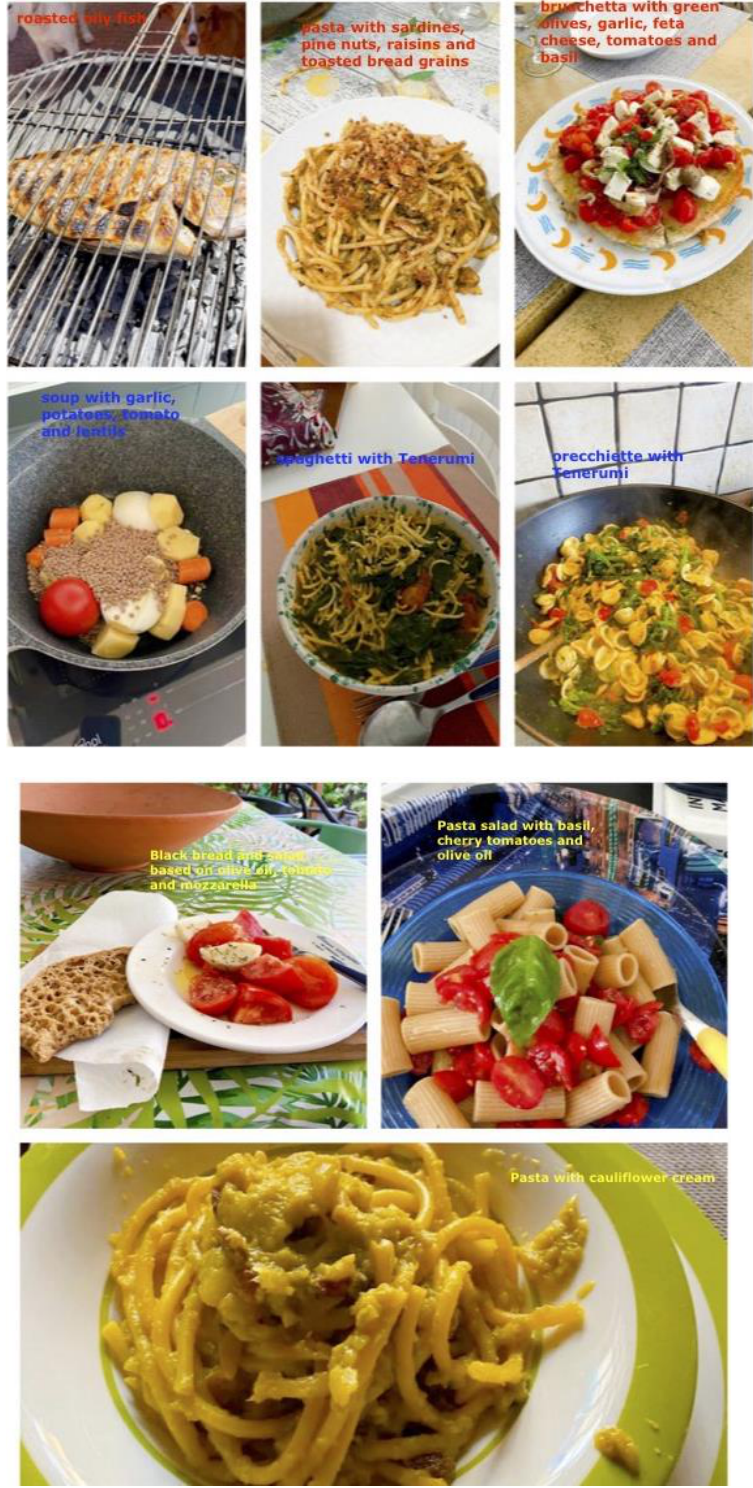
Figure 3. Some typical Mediterranean Italian food.